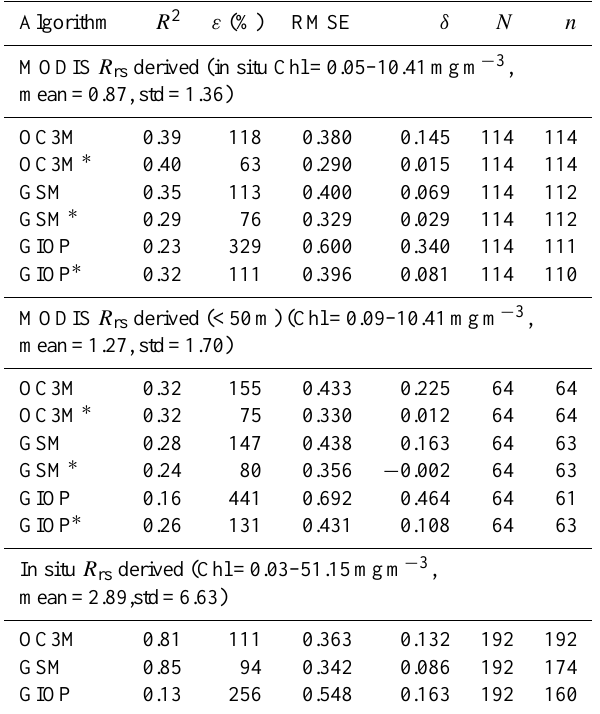
Table 1. Error statistics between derived and in situ Chl.